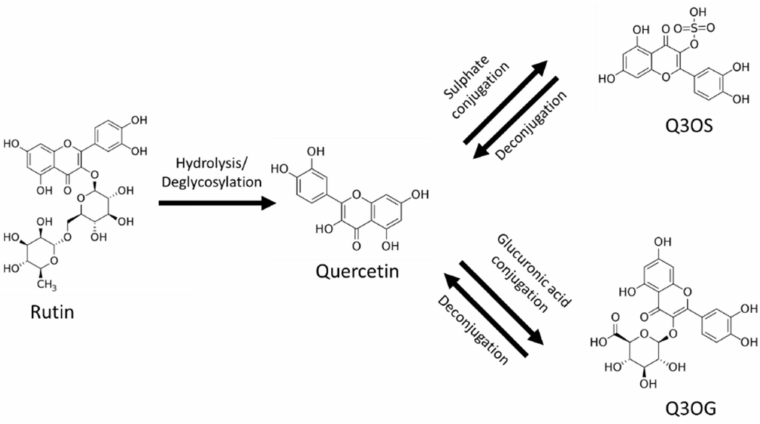
Figure 1. Rutin, quercetin, quercetin-3- O -sulfate (Q3OS), quercetin-3- O -glucuronide